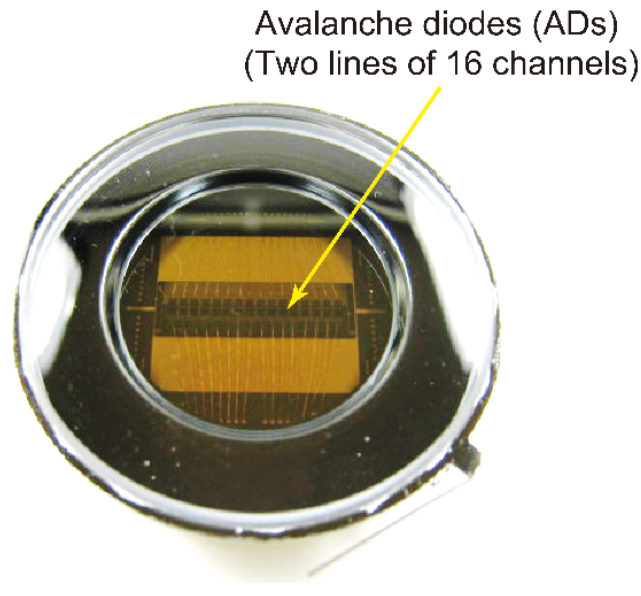
Figure 19. A photograph of the developed multichannel HPD. Adapted with permission from [52]. Copyright 2016, Elsevier.